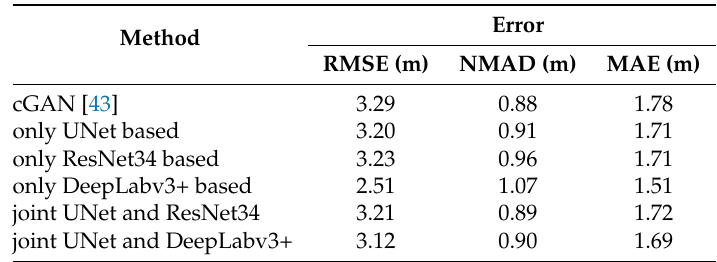
Table 1. Quantitative results for the RMSE, NMAD, and MAE metrics evaluated on 12 selected buildings existing for both input photogrammetric DSM and ground truth LoD2-DSM of the area depicted in Figure